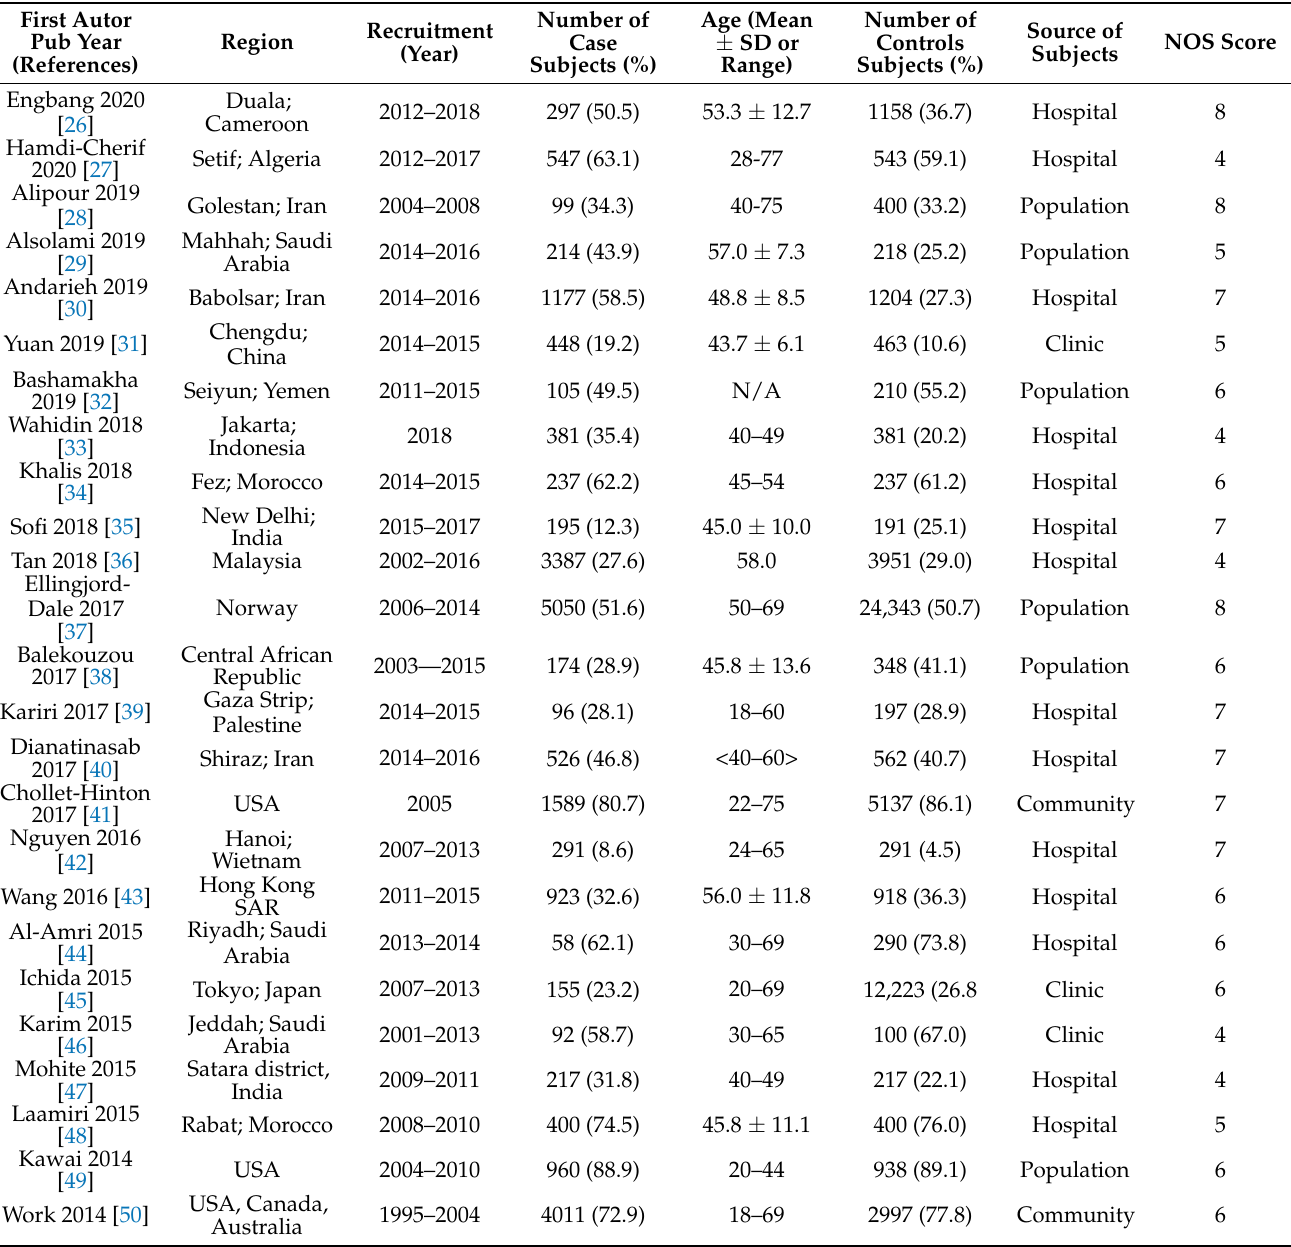
Table 1. Characteristics of the case-control studies included in the meta-analysis on the association between OC use and BrCa